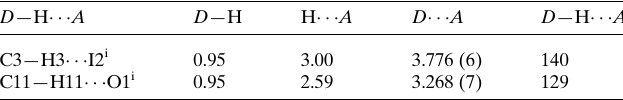
Table 1 Hydrogen-bond geometry (A˚ , (cid:3) ).